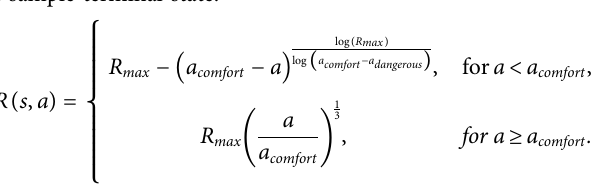
FIGURE 5 | Reward distribution for actions at the terminal state. FIGURE6| Humans R max (cid:1) 10 p ( 1 / s ) 0 . 1 . Figure 5 indicates the reward distribution for